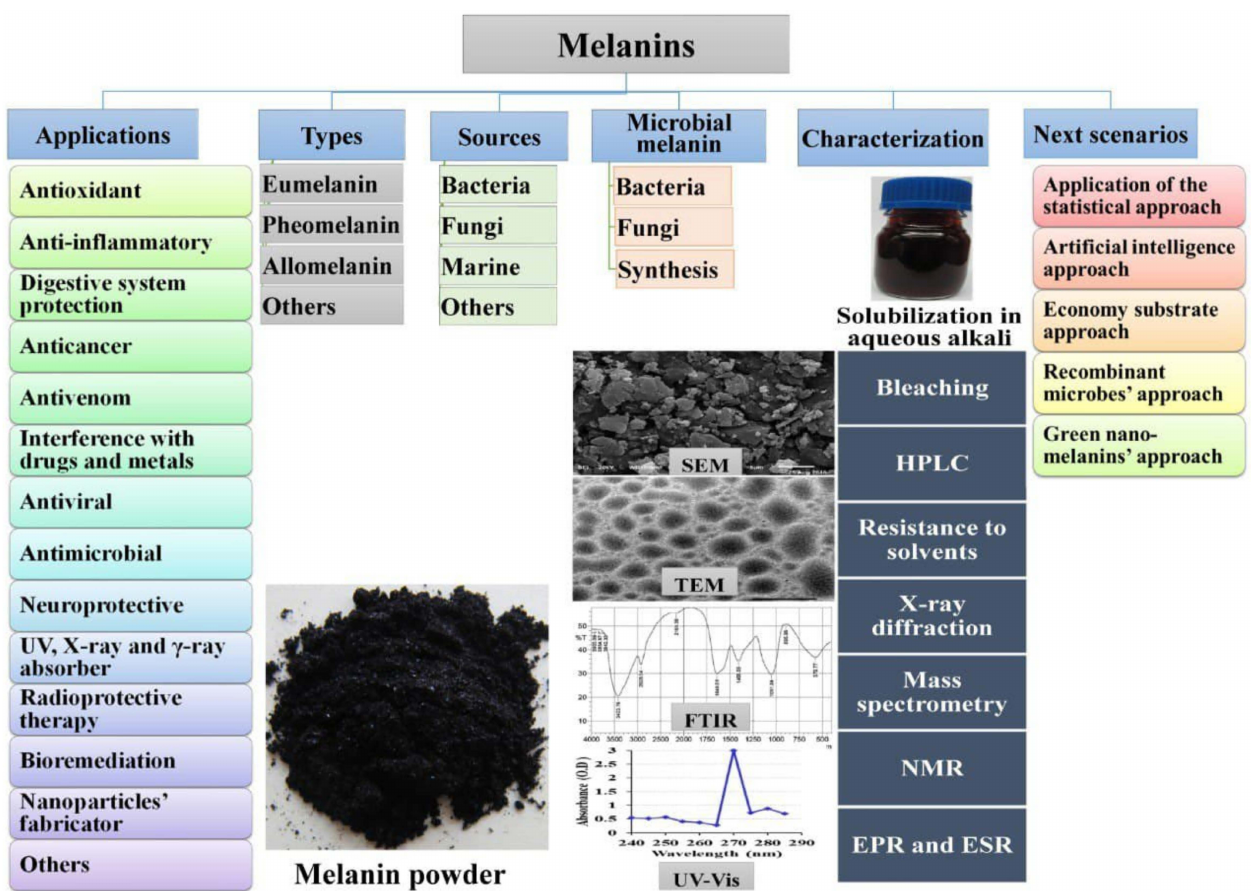
Figure 1. Diagrammatic scheme of the various topics covered by the current